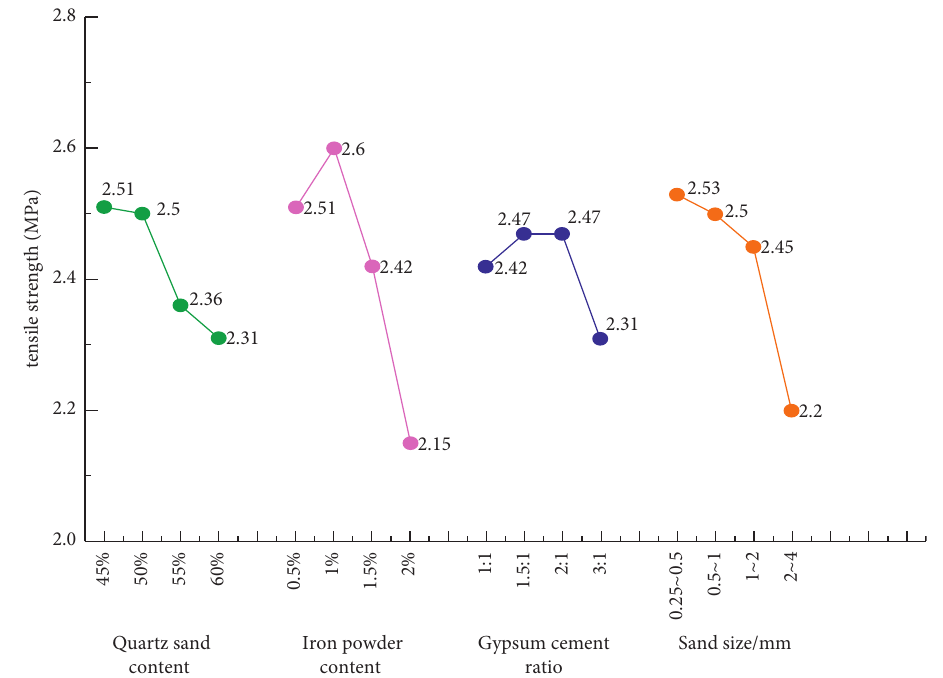
Figure 8: Influence of various factors on tensile strength of similar materials covered by the study. Table 6: Analysis of the extreme difference in tensile strength of various factors covered by the study.